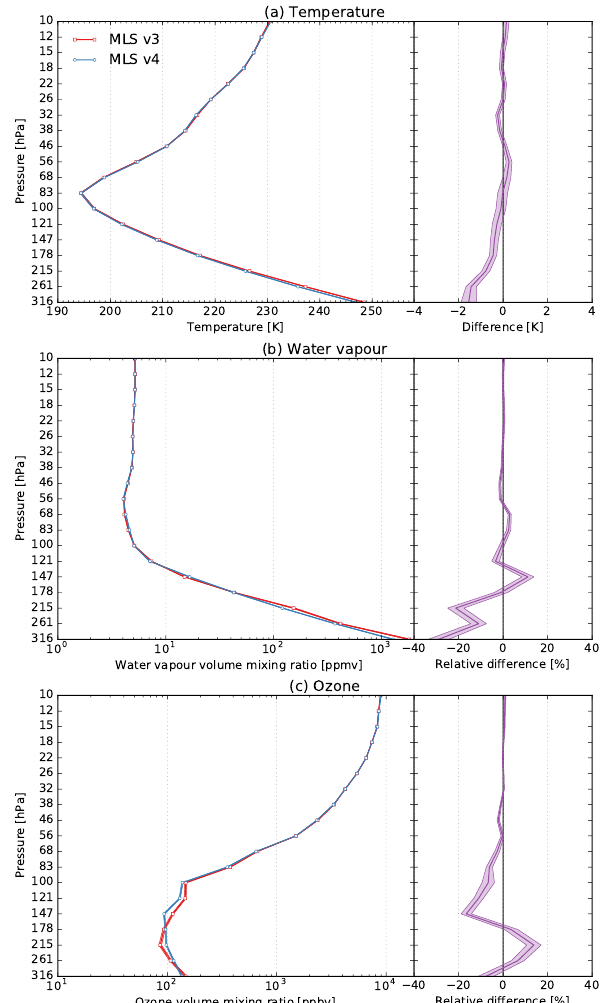
Figure 2. Mean profiles of (a) temperature, (b) water vapour vol- ume mixing ratio and (c) ozone volume mixing ratio from MLS v3 and MLS v4 within one or more of the circular shaded areas outlined in Fig. 1 during the months corresponding to the four mea- surement campaigns (August 2010, August 2011, May–July 2012 and June–July 2014). Differences (v4 minus v3) are shown on the right. Relative differences in water vapour and ozone are calculated relative to v3 mixing ratios. Uncertainty bounds represent combined measurement (estimated retrieval precision) and statistical (twice the standard error of the mean)